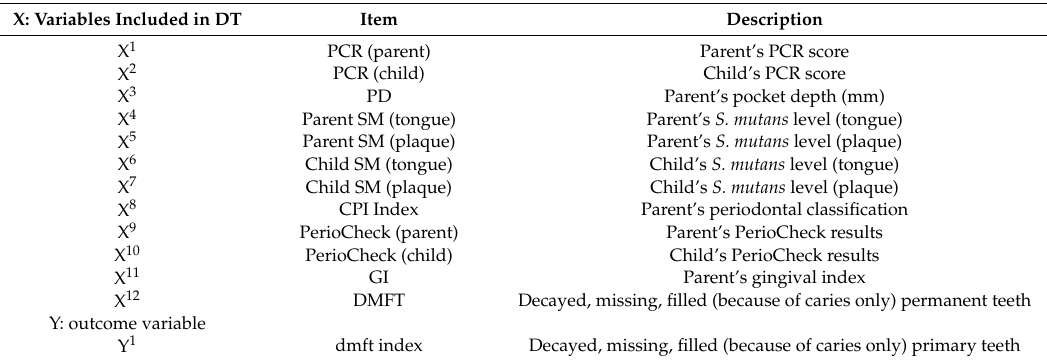
Table 1. Attributes included in the DT (decision